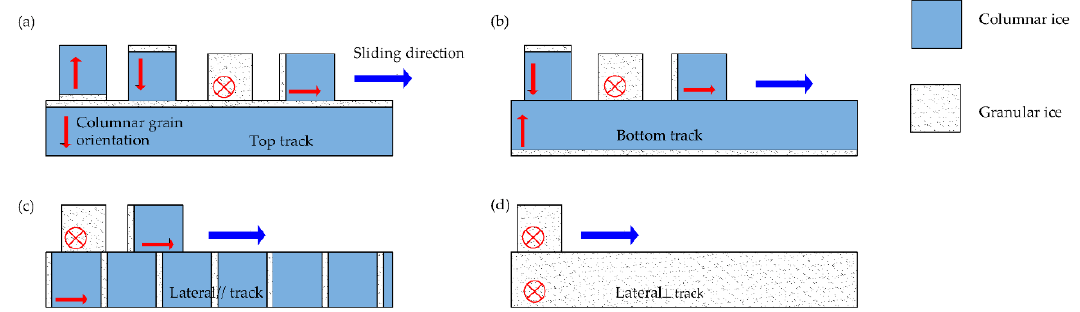
Figure 3. Sliding configurations for ice-ice friction tests: ( a ) Top-Top, Bottom-Top, Lateral ⊥ -Top, and Lateral//-Top; ( b ) Bottom-Bottom, Lateral ⊥ -Bottom, and Lateral//-Bottom; ( c ) Lateral ⊥ -Lateral // and Lateral//-Lateral//; ( d ) Lateral ⊥ -Lateral ⊥